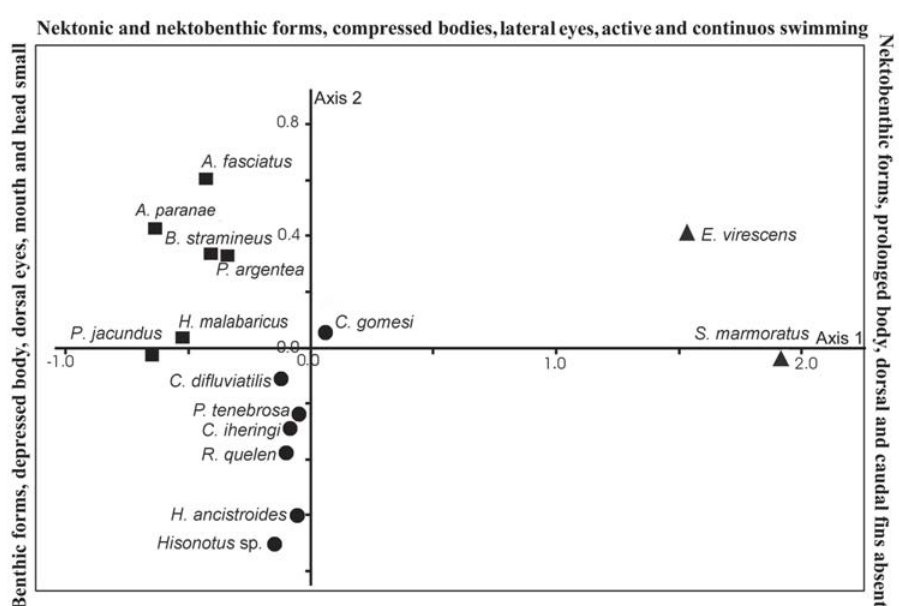
Fig. 12. Projection of the 15 studied species in the two first axes of the PCA; squares represent the nektonic species; circles the benthic and the triangles the